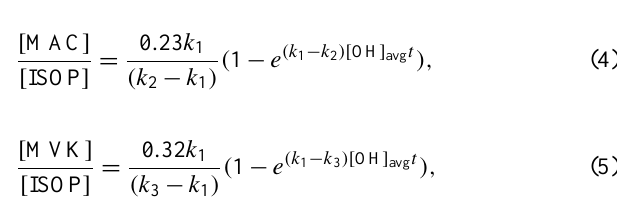
Fig. 5. Combined wind rose maps at daytime hours during the sampling period at (a) TMS and (b) TW.